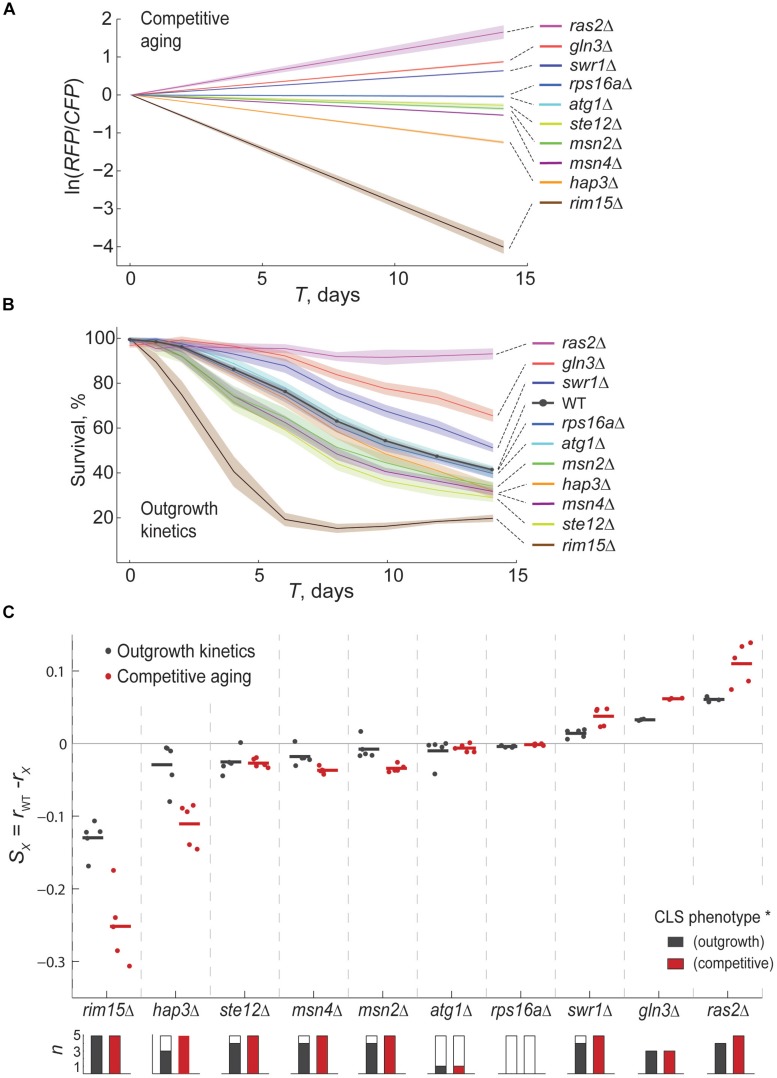
The competitive-aging method is accurate and replicable. (A) Relative survivorship estimated by competitive aging. The modeled ln(RFP/CFP) is shown for the WT and ten mutant strains at each Ti point, averaged for at least six technical replicates along with the CI 95% (shaded area). (B) Percent of surviving cells in monoculture over time measured by the shift in outgrowth kinetics; the mean and CI 95% are shown. (C) Average relative survivorship of three to five experimental replicates is shown, expressed either as the difference of individual death rates for monoculture outgrowth kinetics (rwt−rx, black) or as survivorship coefficients for competitive aging (S, red). Each data point is the average of at least six technical replicates of monocultures or competitions in an independent experimental replicate. Horizontal lines are the mean of each data series. Stacked bars below the plot indicate the number of replicate plates per sample; solid fraction indicates the number of significant samples compared with the WT distribution (p < 0.01, t-test; each experimental batch has 31 reference and at least six deletion samples).